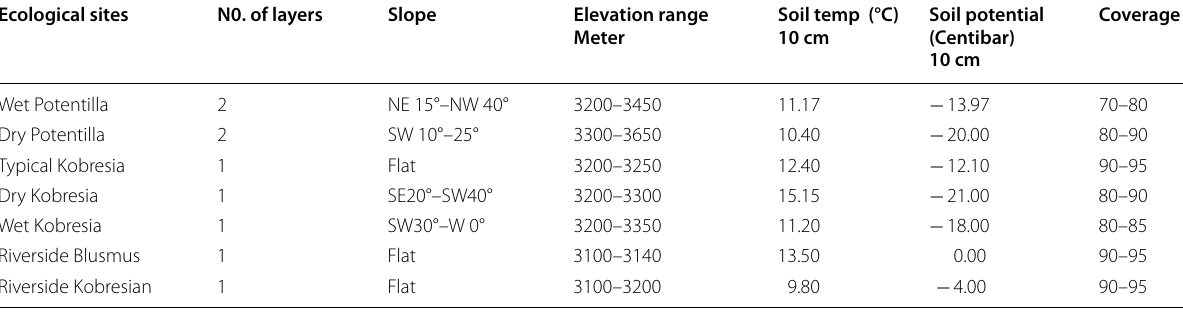
Table.4 Haibei ecological sites’ soil temperature, soil potential, aspect, and elevation range Ecological sites N0. of